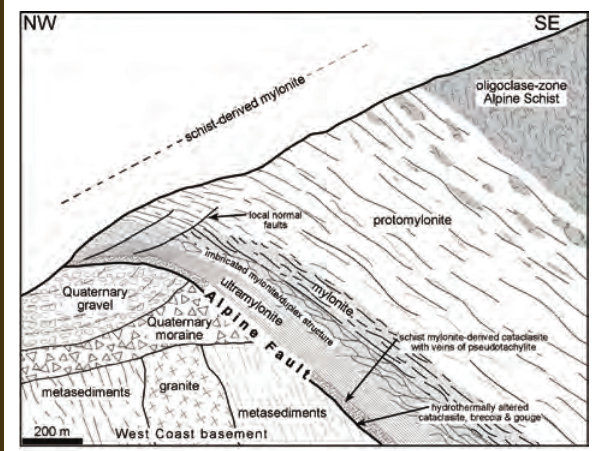
Figure 2. Schematic cross-section of an oblique thrust segment within the central section of the Alpine Fault. Reproduced by permission of the American Geophysical Union after Norris and Cooper, 2007. Copyright 2007 American Geophysical